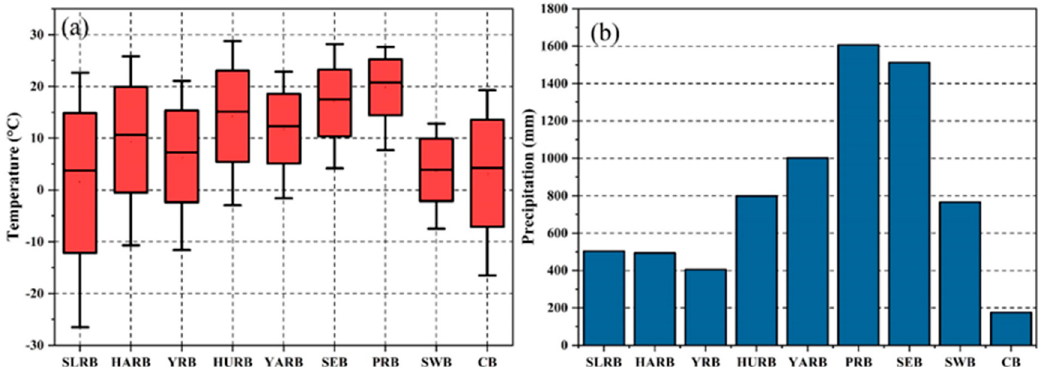
Figure 8. The monthly temperature ( a ) and annual average P ( b ) in 1901–2014 in different river ba-